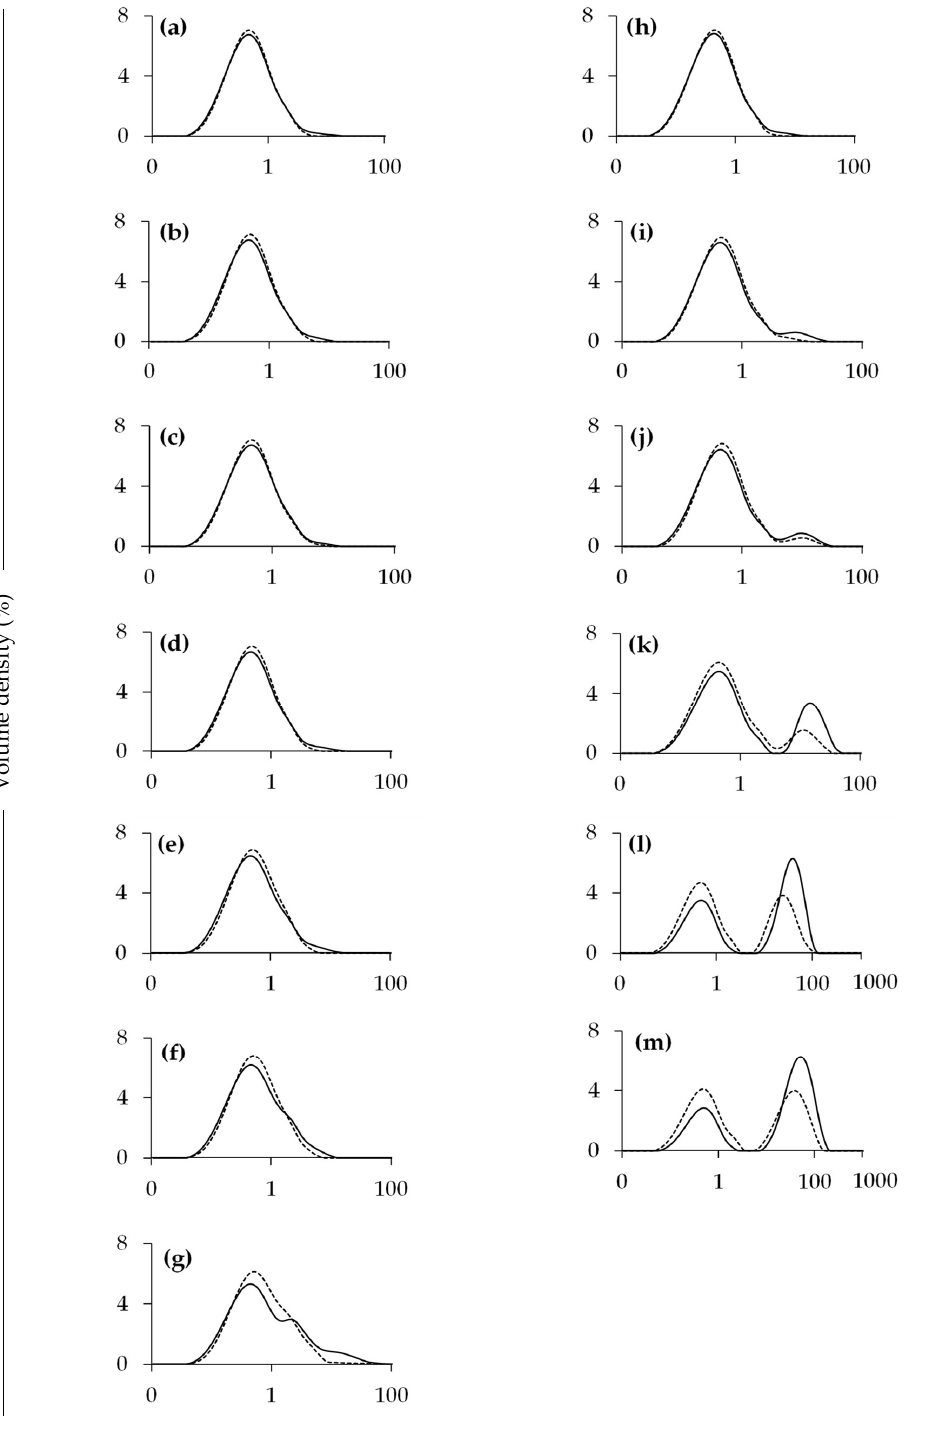
Figure 6. Particle size distribution of lentil protein-stabilised emulsions before (a-g) and after (h-m) heat treatment at 140 °C for 2 min, pH 6.8, without (solid line) or with (dashed line) sodium dodecyl sulphate. Samples had 0 (a and h), 2 (b and i), 3 (c and j), 4 (d and k), 5 (e and l), 6 (f and m) and 10 (g) mM added calcium chloride.